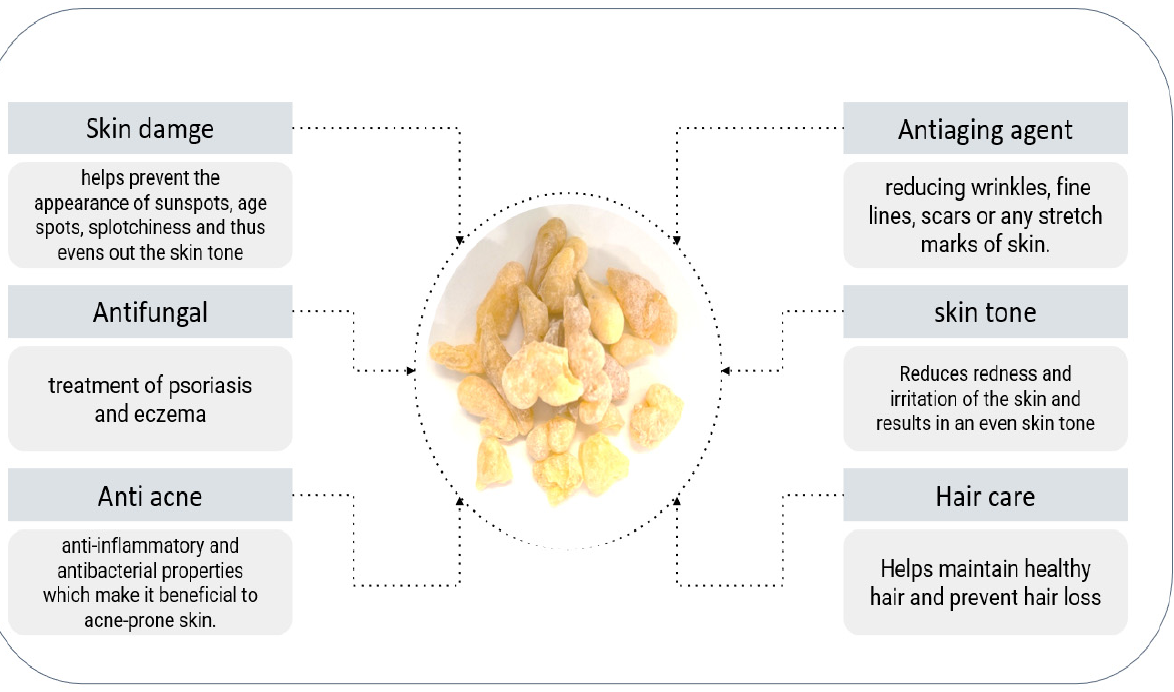
Table 2. Cosmetic products containing C. myrrha.